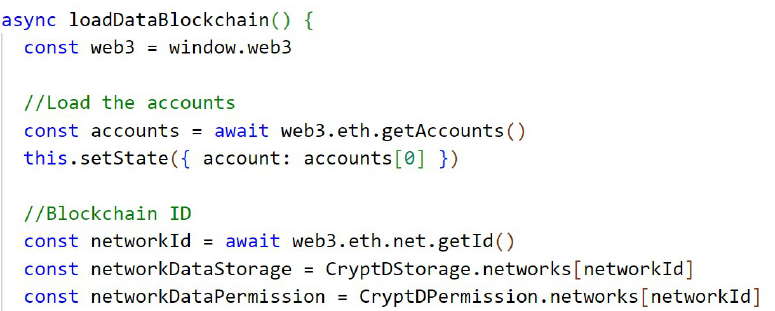
Figure A2. Loading account, fetching network ID, and contract data.